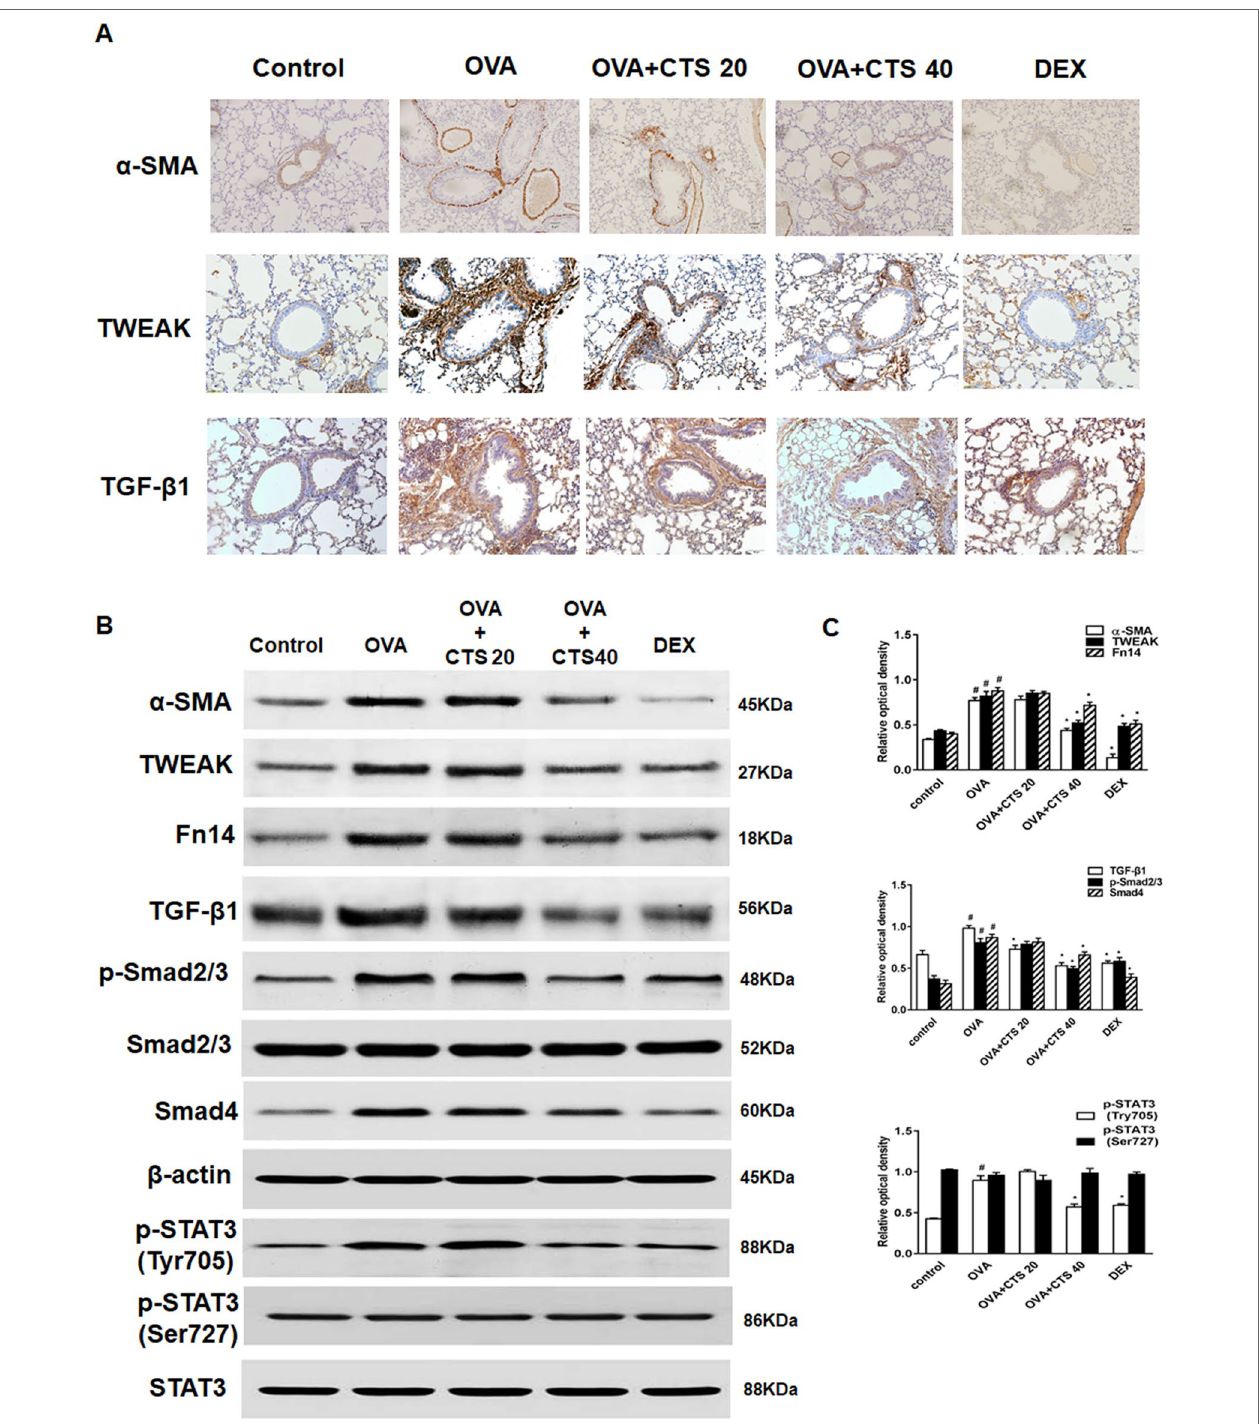
FIGURe 3 | Effect of cryptotanshinone (CTS) on the expression of α-SMA, tumor necrosis factor-like weak inducer of apoptosis (TWEAK), transforming growth factor (TGF-β1), and STAT3 in the lung tissues. (A) Immunohistochemical staining was performed to assess the distribution of α-SMA. Magnification was 100×; Scale bar = 200 μm. (B) The expressions of α-SMA, TWEAK, Fn14, TGF-β1, Smad4 and phosphorylation of Smad2/3 and STAT3 were analyzed by Western blot. β-actin and STAT3 were used as the standard controls. (C) The band intensities of these proteins were expressed as a ratio to β-actin and STAT3. Data were shown as mean ± SEM (n = 8). #P < 0.05 vs. untreated mice; *P < 0.05 vs. OVA-treated mice. Control [phosphate buffered saline (PBS)-inhaled mice administered with PBS], ovalbumin (OVA) (OVA-inhaled mice administered with PBS), OVA+CTS 20/40 (OVA-inhaled mice administered with 20 mg/kg or 40 mg/kg CTS), and dexamethasone (DEX) (OVA-inhaled mice administered with